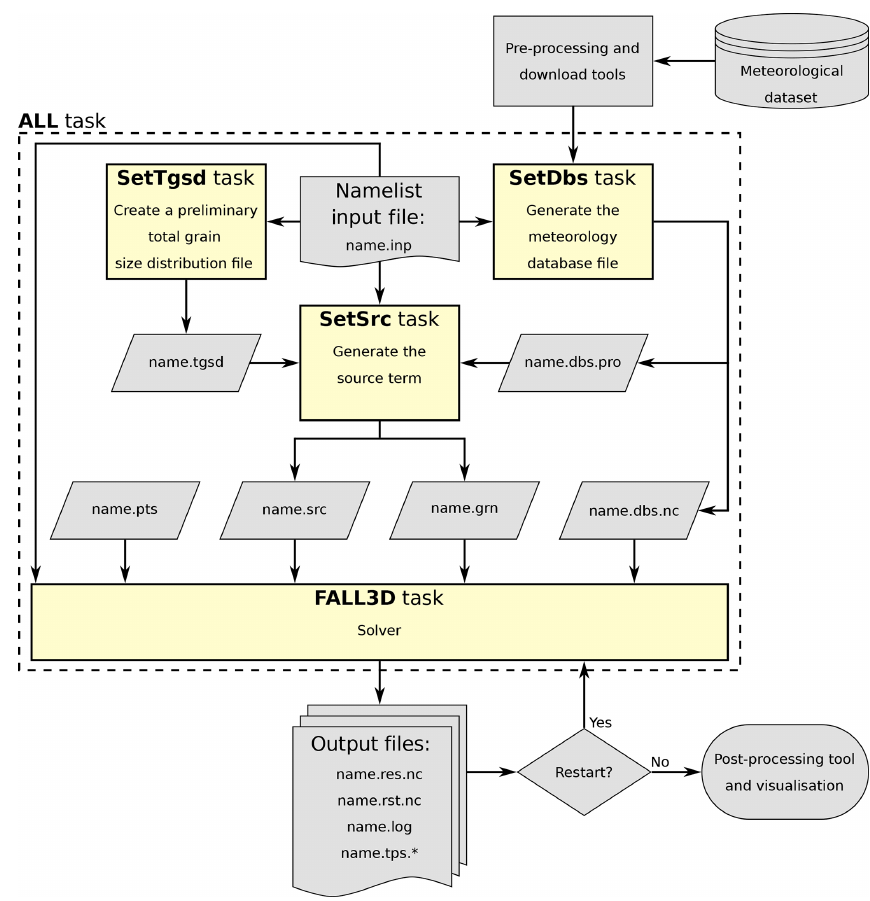
Figure 6. Pre-process and execution workflow and associated model tasks. Task All runs all tasks in a single (parallel) execution. In this case, the write/read of the intermediate files can be omitted. All tasks share a unique model input file